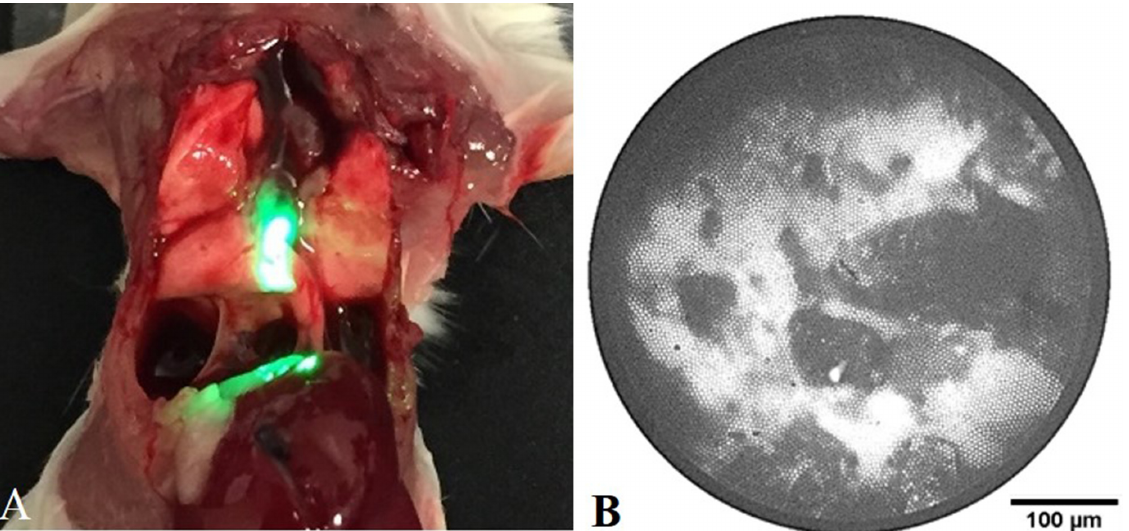
Fig 3. Intravital excitation illumination via microendoscope in the mouse airway. (A) Image of sacrificed mouse with open chest wall and intravital illumination showing the proximal placement of the fiber bundle in the trachea. (B) Example fiber bundle image of BCG17 bacterial fluorescence collected with the microendoscope CCD. The microendoscope image is used to guide placement of the intravital source in contact with tissue prior to IVIS imaging.